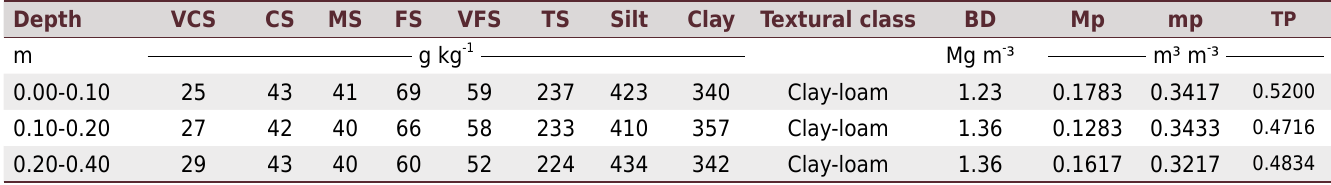
Table 1. Particle size analysis, soil bulk density, macropores, micropores, and total porosity of a Cambissolo Háplico Ta Eutrófico (Cambisol; Inceptisol) in an experimental area in São Gabriel, Irecê Identity Territory, Bahia, Brazil Depth